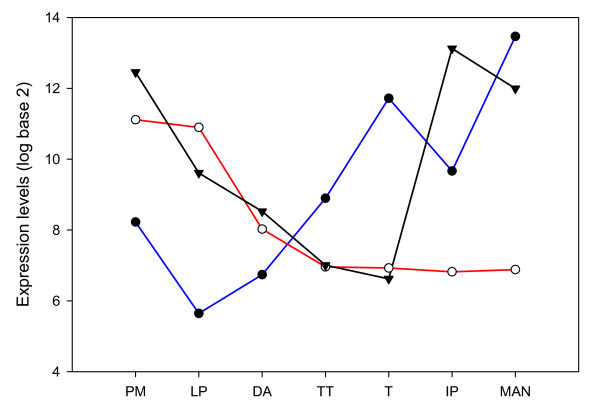
Three novel candidates with significant expression variability across the seven stages investigated. TaAffx.38162.1.S1_at (blue), TaAffx.9800.1.S1_at (black) and TaAffx.60258.2.S1_s_at (red) are highlighted. TaAffx.38162.1.S1_at shows more than a 64-fold increase in expression from LP to T, while TaAffx.9800.1.S1_at drops approximately 64-fold from PM to T. TaAffx.60258.2.S1_s_at is also down-regulated from PM to T approximately 16-fold. PM, LP, DA, TT, T, IP and MAN are as described in Figure 1.